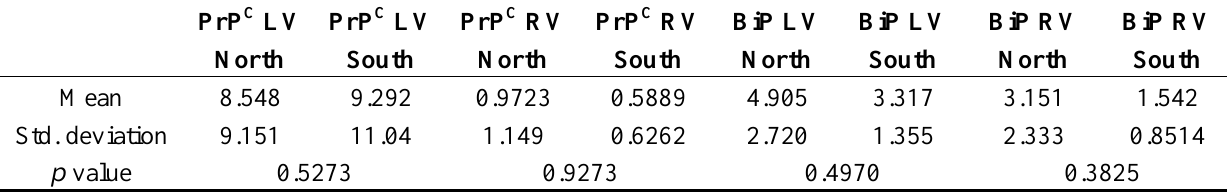
Table 5. Children PrP C and GRP78/BiP fold increase results for left ventricle (LV) and right ventricle (RV), North vs. South